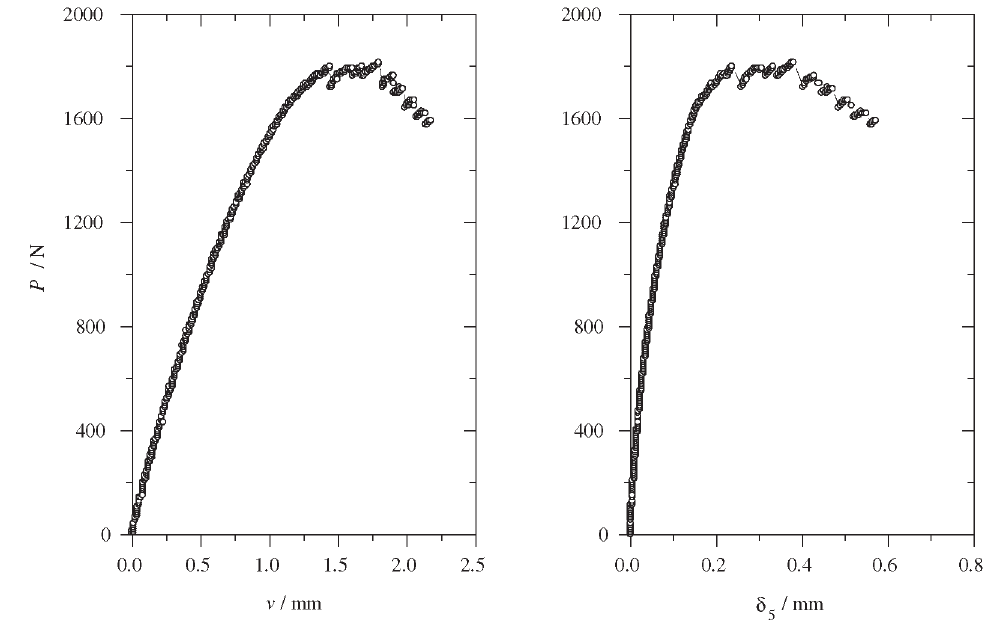
Figure 5. P vs. v and P vs. δ